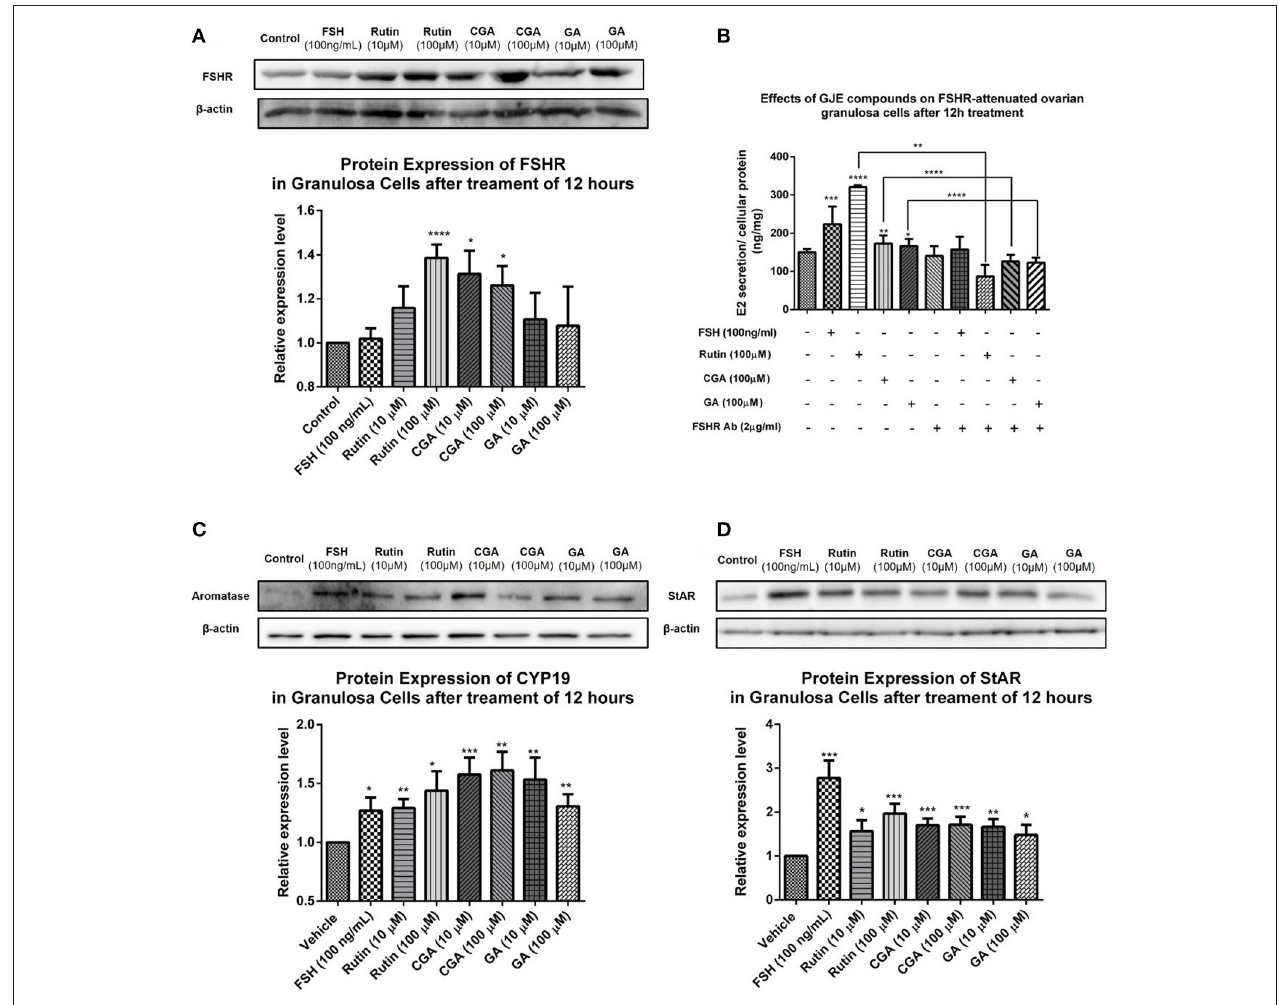
FIGURE 11 | Effects of rutin, CGA, and GA on levels of FSHR, aromatase and StAR in ovarian granulosa cells after 12h of treatment. (A,C,D) Effects of rutin, CGA, and GA on FSHR, aromatase and StAR expression in ovarian granulosa cells. Ovarian granulosa cells of SD rats were treated with various concentrations of rutin, CGA, and GA respectively for 12h, respectively, and then total cell lysates were extracted for Western blot analysis by using antibodies specific to FSHR, aromatase and StAR. The representative image and the relative expression levels of FSHR, aromatase and StAR are shown. (B) Estrogen stimulating effect of rutin, CGA, and GA on ovarian granulosa cells with antibody-blocked FSHR diminished. The data were normalized with the internal control β -actin, each value is the mean ± SEM ( n = 4), with * p < 0.05, ** p < 0.01, *** p < 0.001, **** p < 0.0001 vs. vehicle control